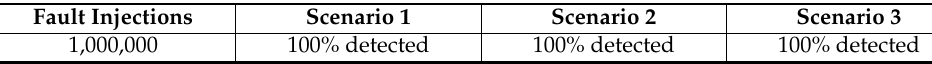
Table 4. Robustness results of the secured